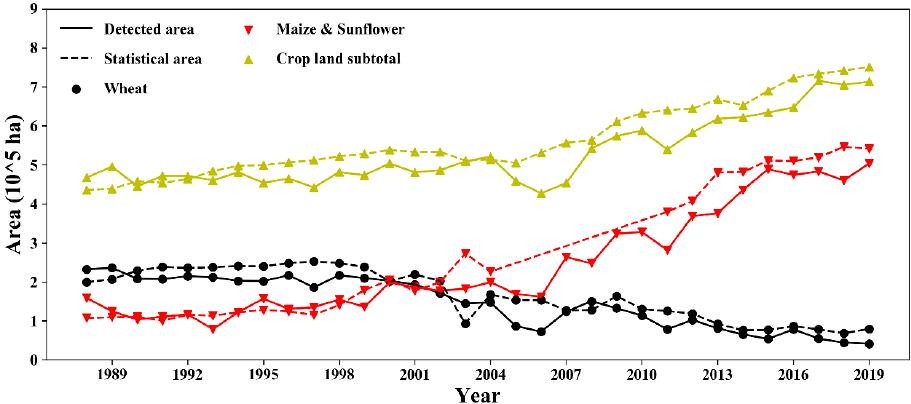
Figure 8. The evolutionary progress of cropping structure in Hetao from 1988 to 2019. The dashed lines represent the statistical area of Bayan Nur city. The solid lines are the detected cropland area in the Hetao Irrigation District.